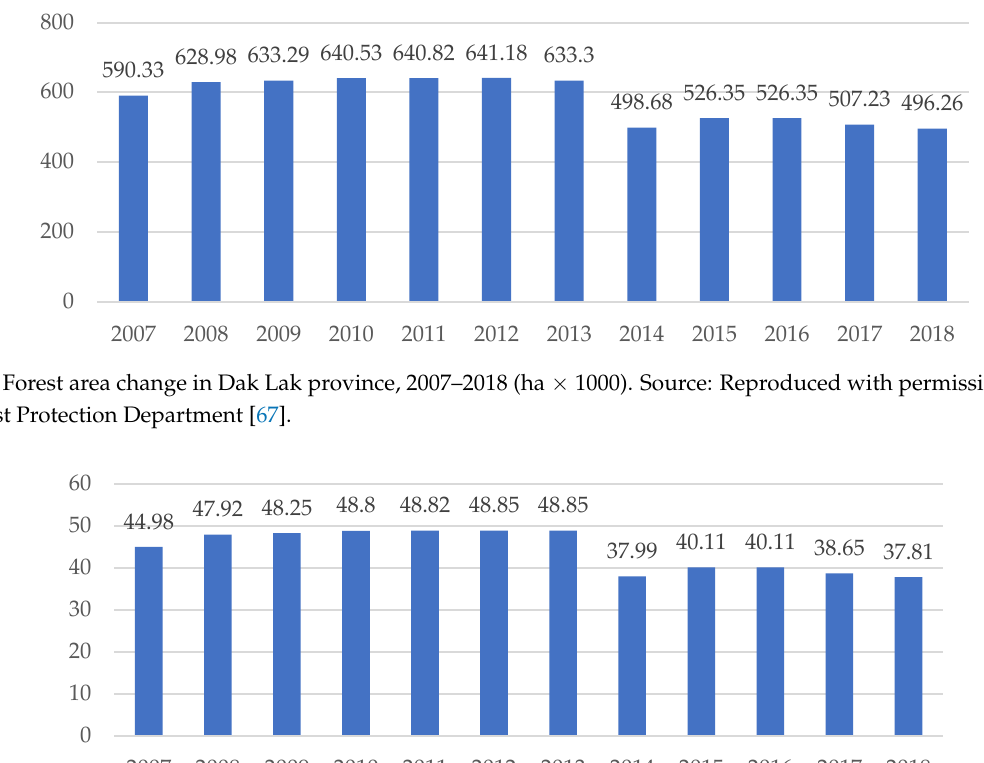
Figure 5. Forest cover change in Dak Lak province, 2007–2018 (%). Sources: Reproduced with per- mission from Dak Lak Forest Protection Department [67].